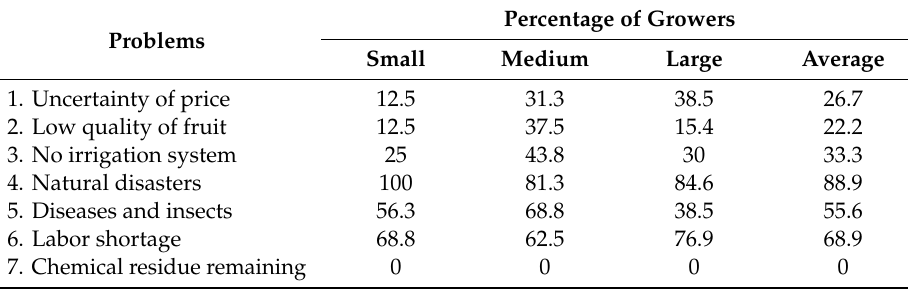
Table 7. Problems faced by mango growers during production supply